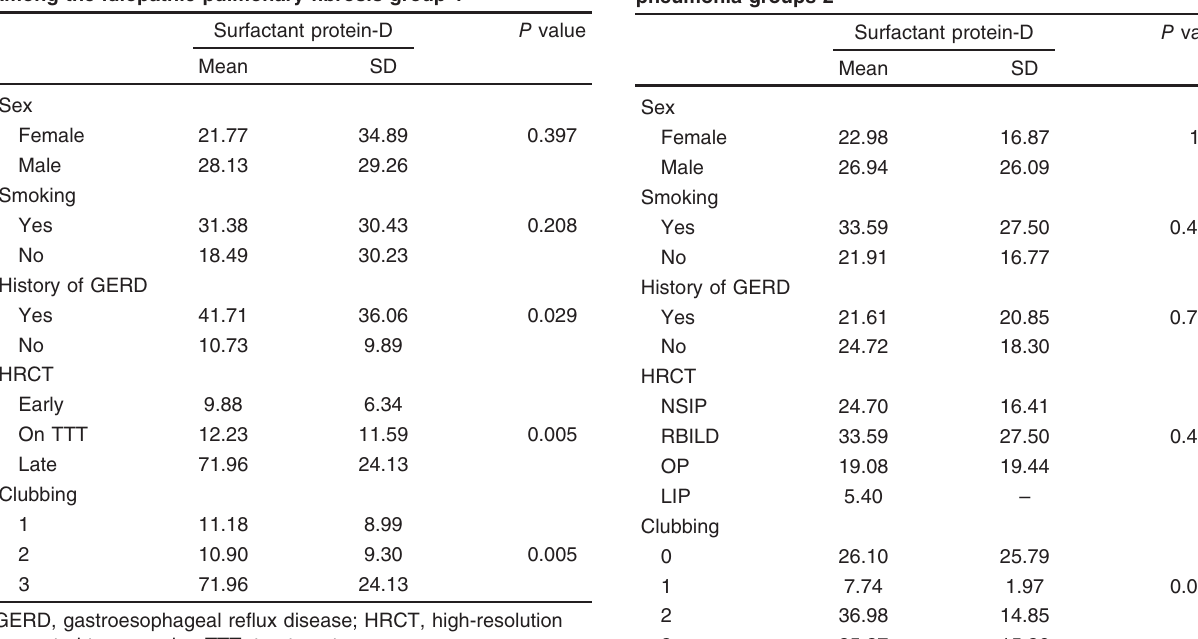
Table 5 The mean and SD of surfactant protein-D level in relation to sex, smoking, gastroesophageal reflux disease history, high-resolution computed tomography, and clubbing among the idiopathic pulmonary fibrosis group 1